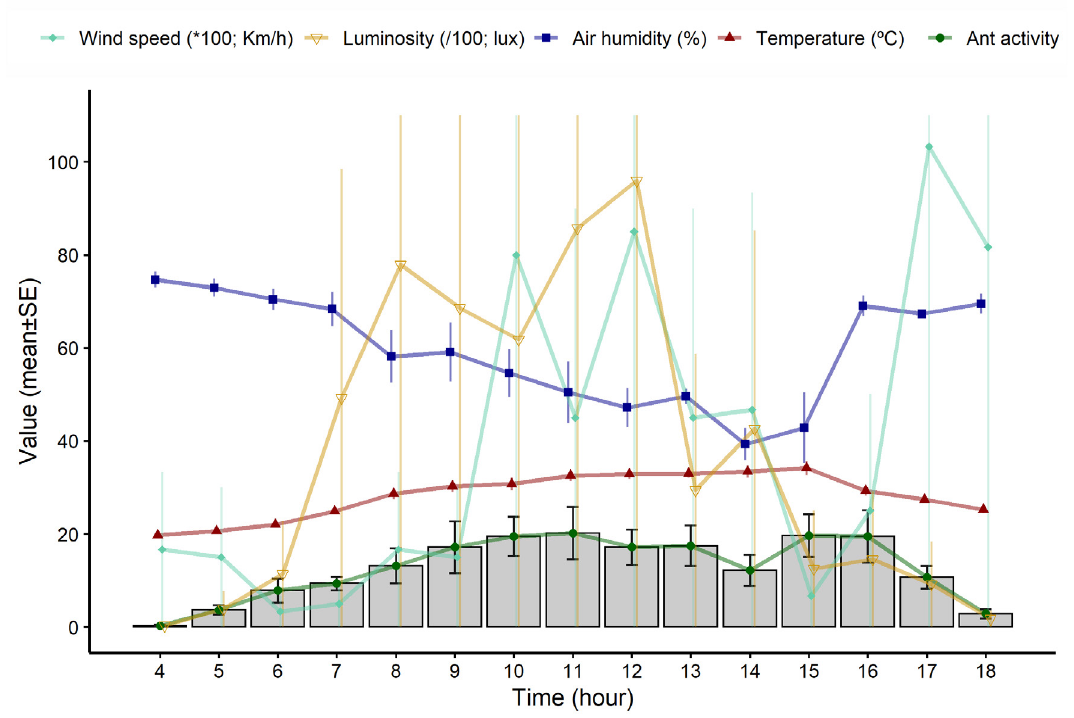
Fig 1 . Means of the number of ants from six colonies of Cephalotes borgmeieri leaving the nest from 4:00 a.m. to 6:00 p.m. (line with closed circles) and variation of temperature values (closed triangles), air humidity (closed squares), luminosity (open triangles) and wind speed (closed diamonds) recorded on the campus of the University City, Dourados, Mato Grosso do Sul, Brazil. (Symbols indicate the average values and confidence intervals indicate the standard